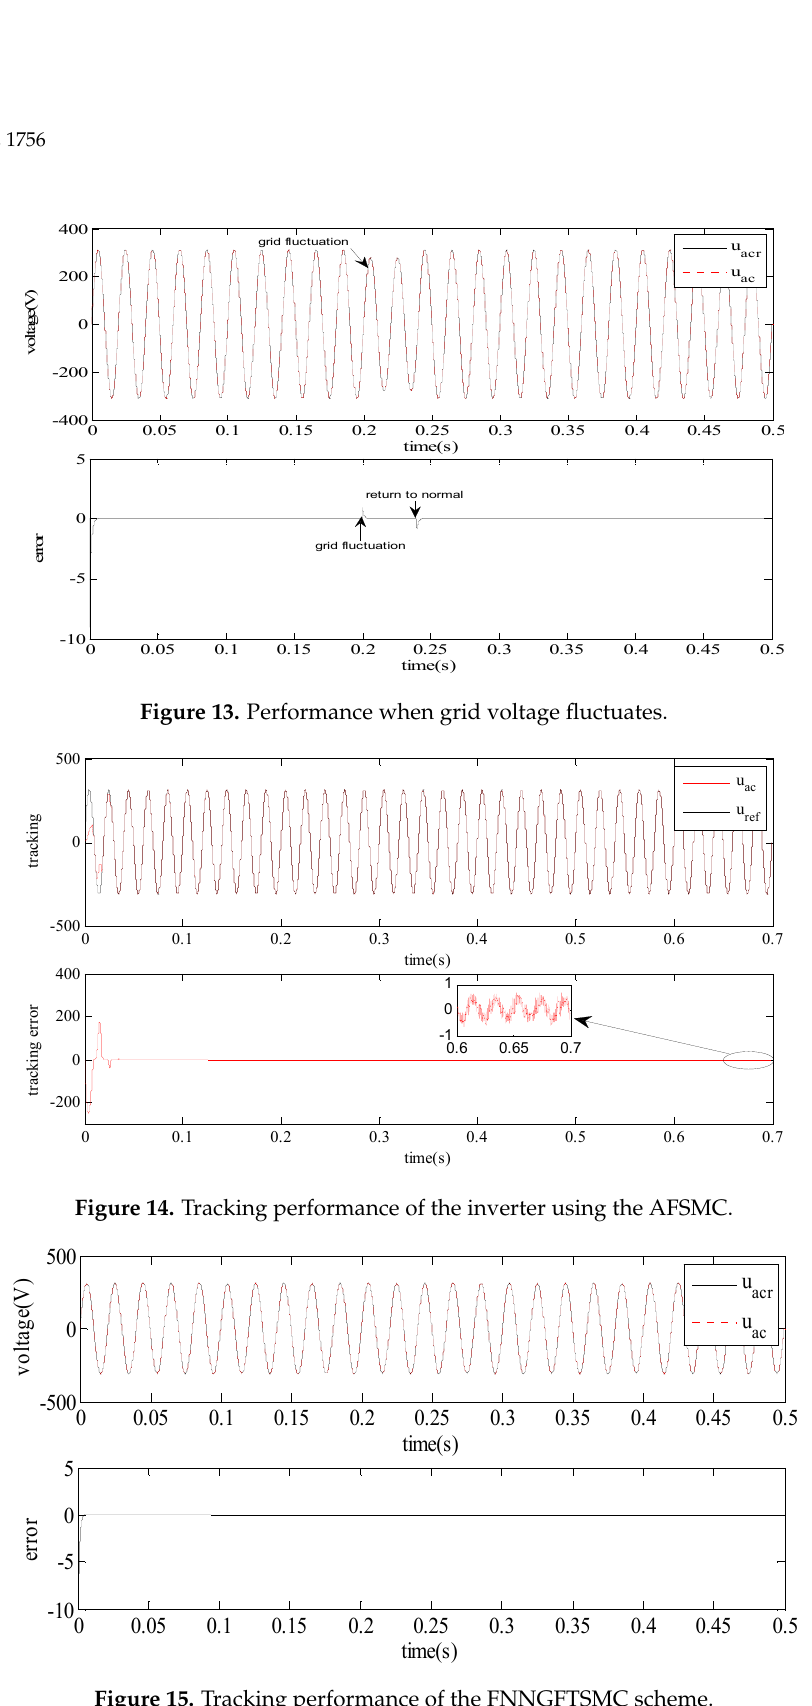
Figure 15. Tracking performance of the FNNGFTSMC scheme.